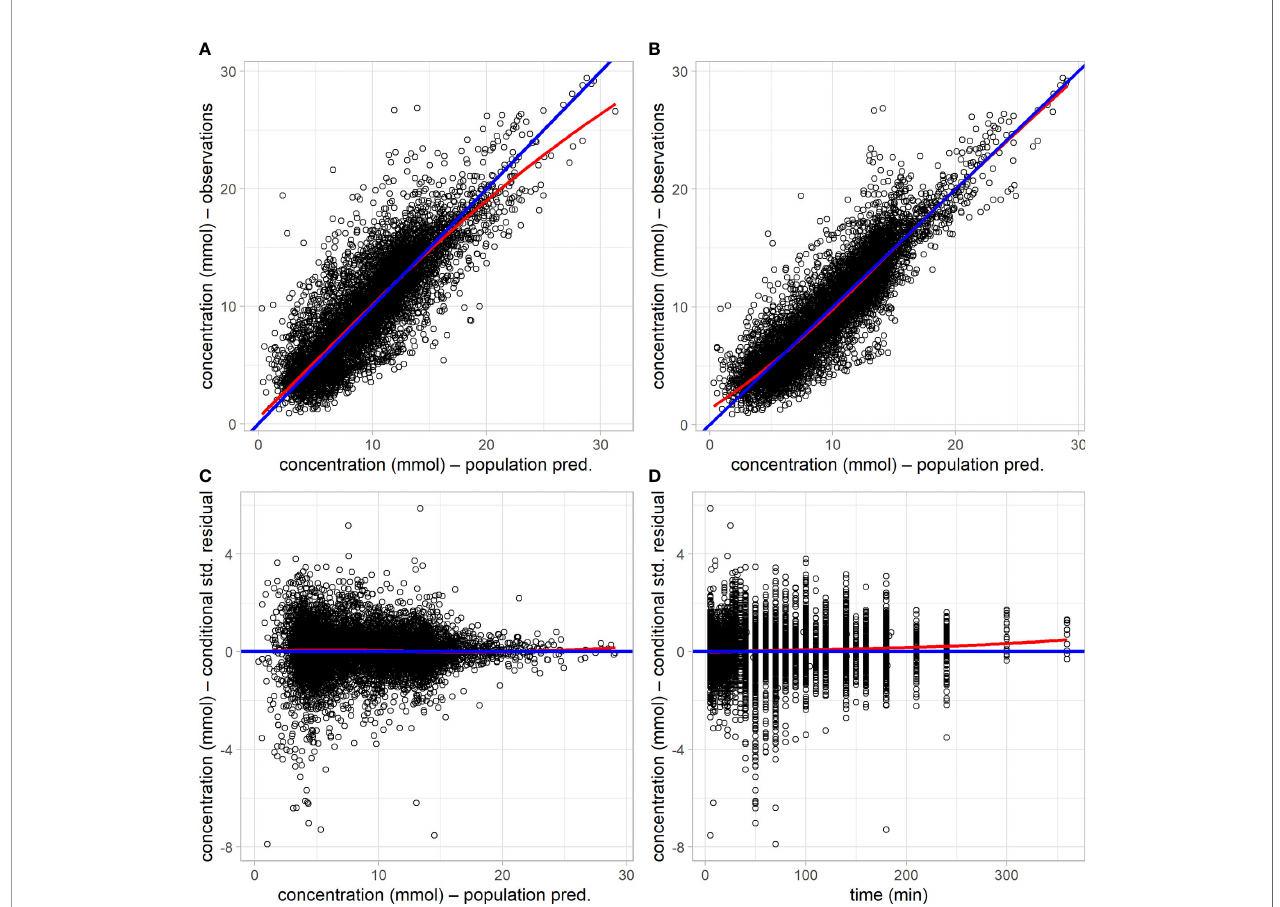
FIGURE 2 | Goodness-of- fi t plots of the base model without covariates and the fi nal model with covariates. (A) observed glucose concentration versus population prediction from the base model. (B) observed glucose concentration versus population prediction from the fi nal model. (C) conditional standardized residuals versus population prediction in the fi nal model. (D) conditional standardized residual in the fi nal model versus time. Blue lines are the lines of identity or zero value; red lines are loess smooth